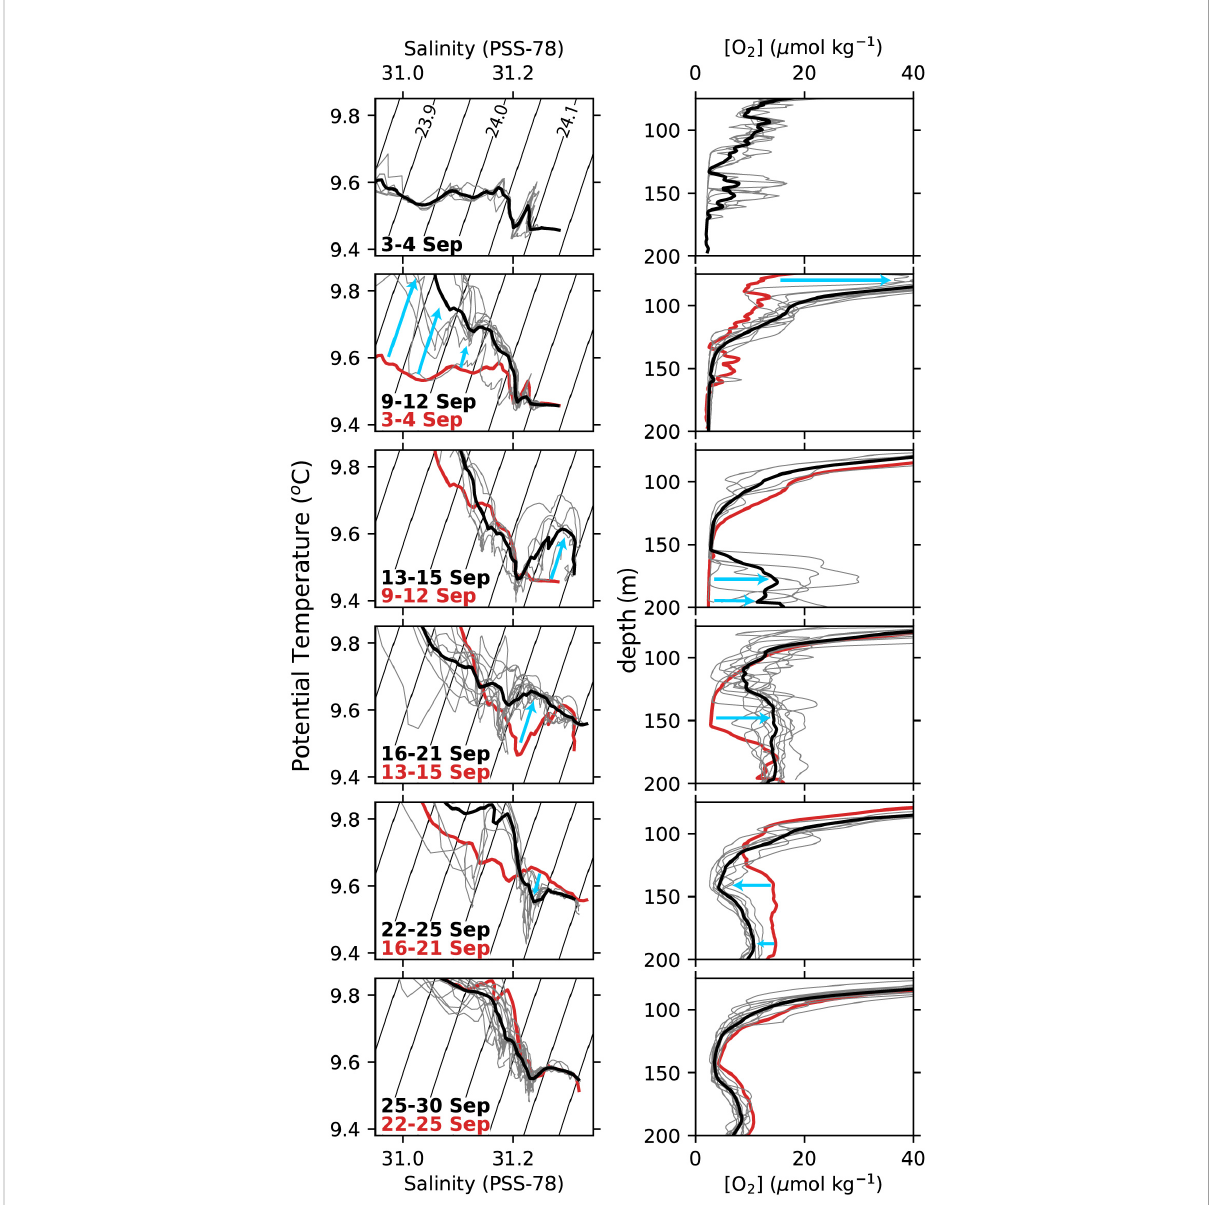
FIGURE 6 Detailed pro fi les over the Sept 2016 renewal event. Left hand panels show T-S diagrams with potential temperature on the y-axis and salinity on the x-axis. Black contours are lines of constant potential density ( s q kg m -3 , labeled in the top panel). Right hand panels show depth pro fi les of O 2 concentration deeper than 75 m. In each panel thin grey lines show individual pro fi les collected by the pro fi ling mooring during the dates shown in black text, while the thick blackline is the average of the individual pro fi les. Thick red line shows the average of individual lines from the panel above (during the dates shown in red text). Blue arrows highlight changes between the red and black dates. Missing dates indicate missing